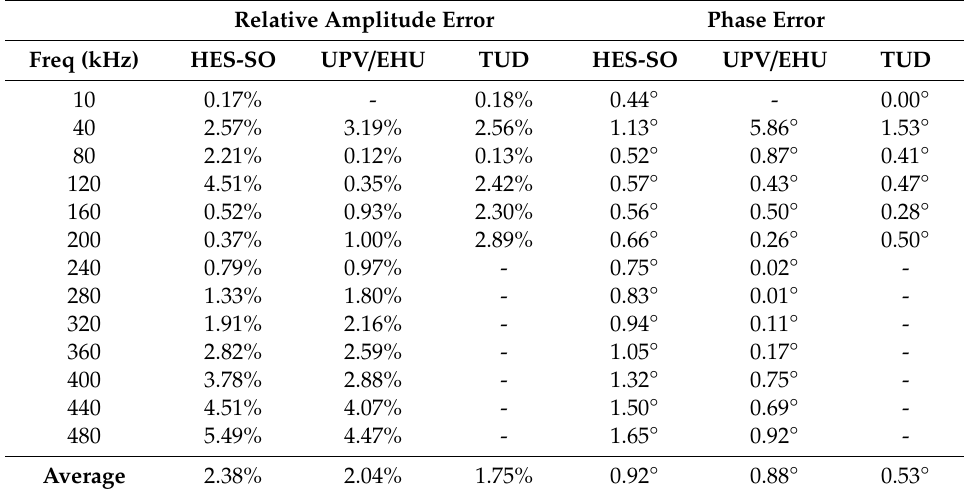
Table 3. Accuracy of the methods in the measurement of filter 2055, with respect to the results obtained by the impedance precision